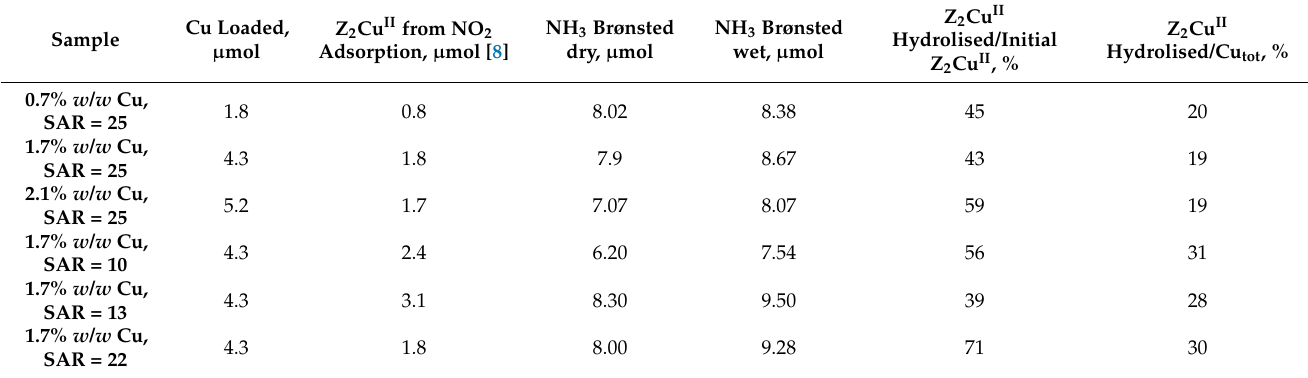
Table 2. Estimates of the fraction of Z 2 Cu II hydrolyzed according to reaction (3).